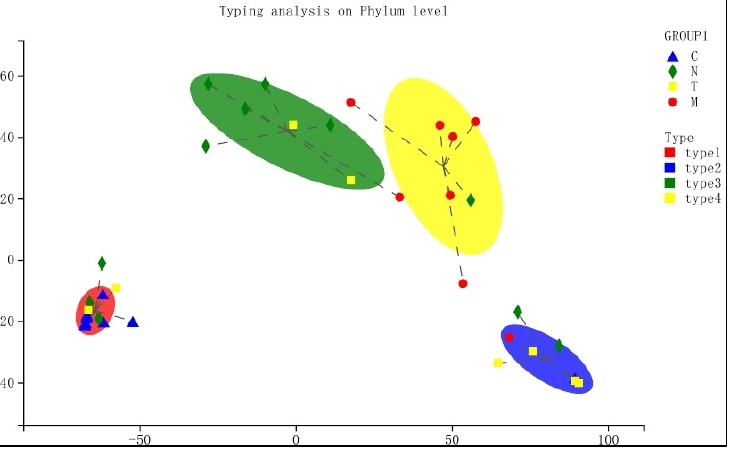
Figure 4. Results of the typing analysis at phylum level, with “groups” referring to different sample groups and “types” referring to different bacterial community composition types. Areas within circles indicate confidence